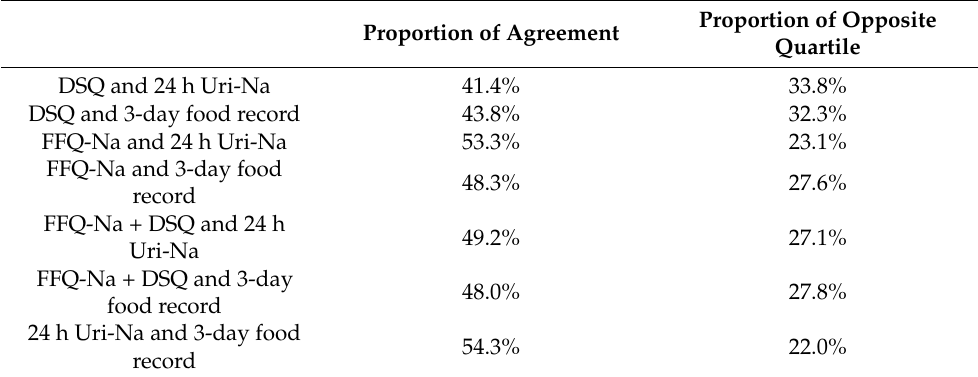
Table 6. Cross-classification results for the DSQ, FFQ-Na, FFQ-Na + DSQ, 24 h Uri-Na and 3-day food record. Proportion of Proportion of Agreement